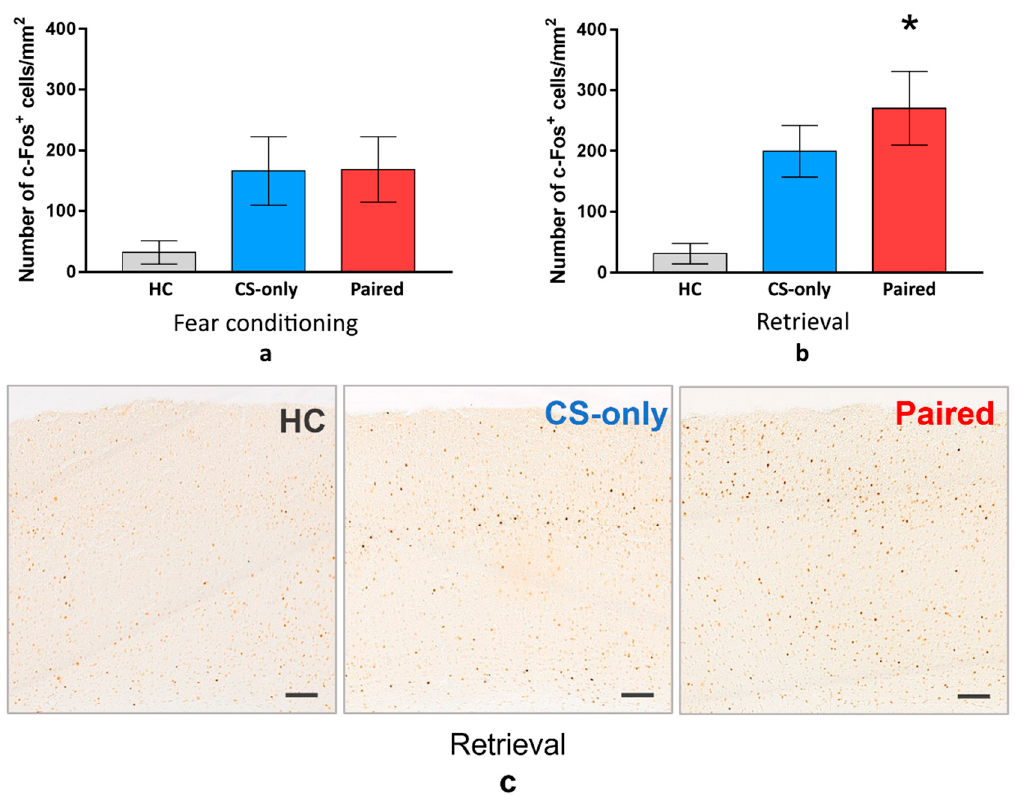
Figure 2. The density of c-Fos-positive cells in the PtA 1 h after ( a ) fear learning and ( b ) memory retrieval on the next day (mean, 95% CI). The density of the PtA c-Fos-positive cells was higher in the Paired and CS-only groups than in the Home cage (HC) group during FC or memory retrieval ( p < 0.001, one-way ANOVA and post hoc Tukey test). During memory retrieval, c-Fos-positive cells density was higher in the Paired group compared with the CS-only group (* p = 0.0364, one-way ANOVA and post hoc Tukey test). ( c ) Image of Fos-positive cells in PtA in HC, CS-only and Paired groups (scale bar is 100 μ m).